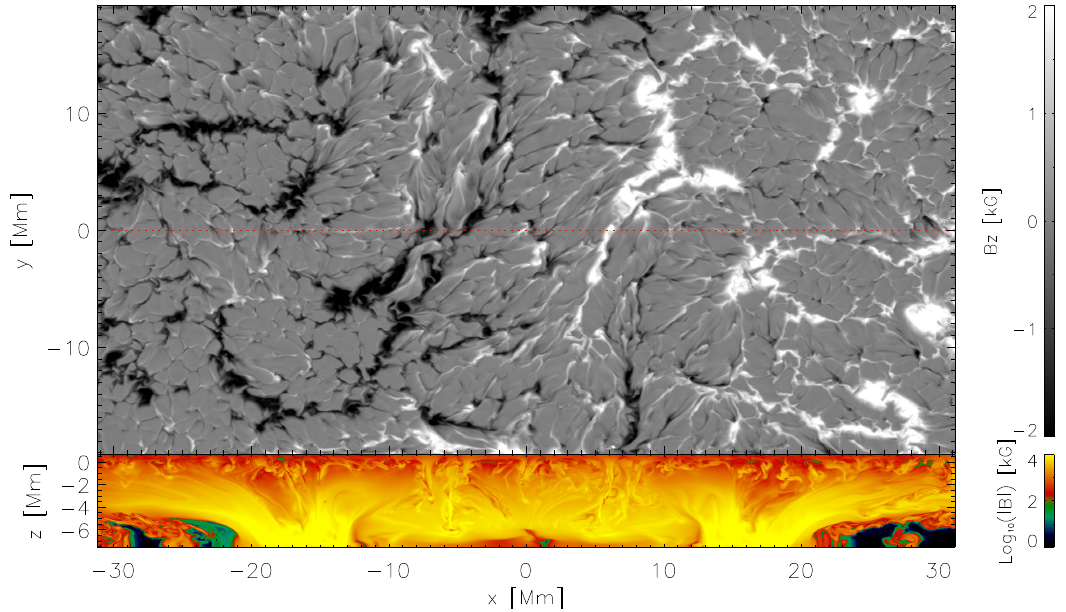
Figure 9: The top panel shows the photospheric distribution of the vertical component of the magnetic field resulting the simulated rise of a semi-toroidal flux tube from at depth of 7.5 Mm to the surface. The bottom panel shows a vertical cross-section (at 𝑦 = 0) of the magnetic field strength in the photosphere and in the subsurface layers captured by the simulation. Due to the density and pressure drop over this height range, the emerged flux is dispersed and covers a much larger area that the subsurface roots of the torus. Image reproduced with permission from Cheung et al. (2010), copyright by